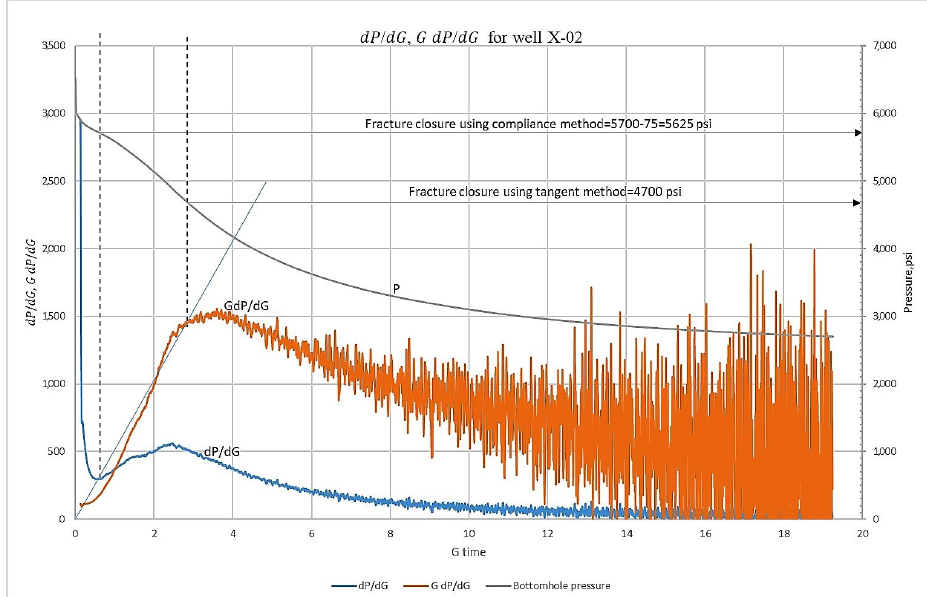
Figure 28. Tangent method (dP/dG and GdP/dG) for well X-02.